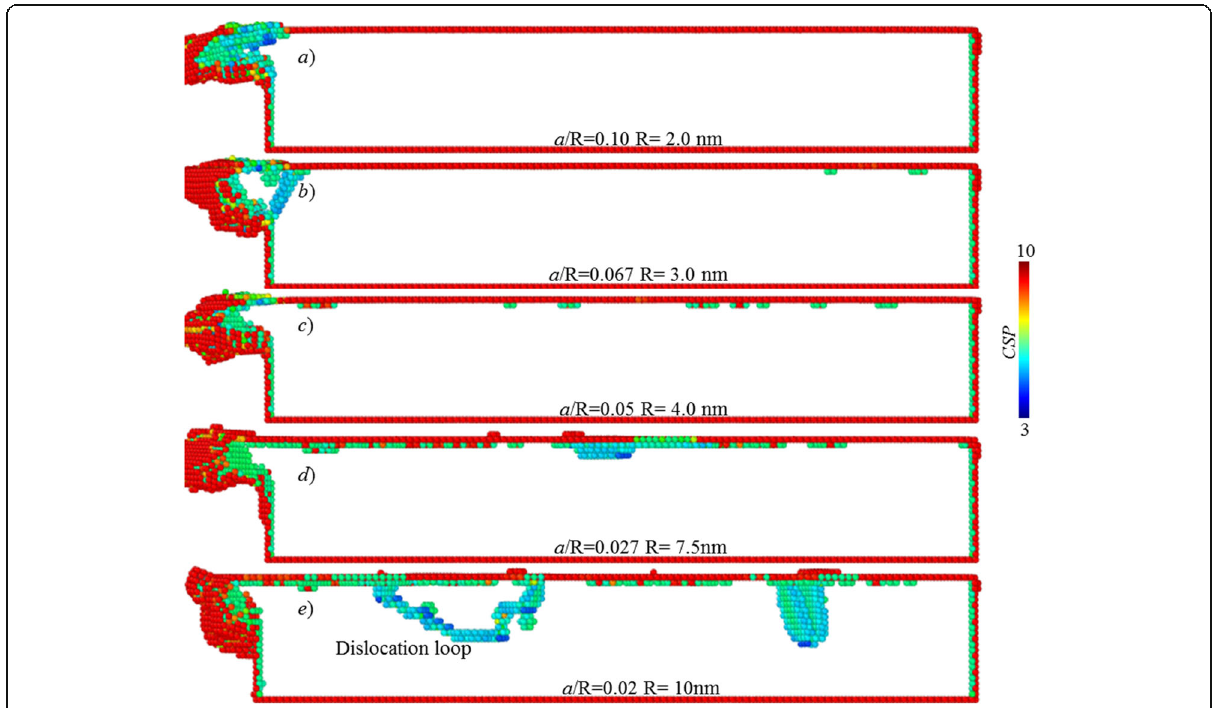
Fig. 9 Subsurface defects at various tool edge radii. Atoms are coloured based on their